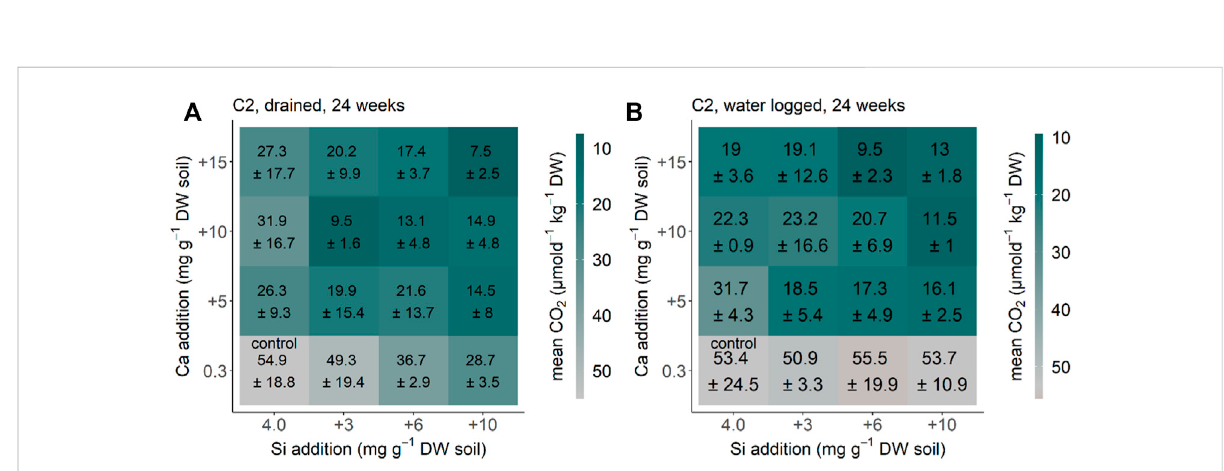
FIGURE 2 CO 2 productionfortheSiberiaCherskyC2fromNE-Russiaafter24 weeks (A) drainedand (B) waterloggedincubation.Eachsquarerepresentsa treatment(n=5)withSi(+0,+3,+6,and+10 mg g − 1 DW)andCa(+0,+5,+10,and+15 mg g − 1 DW).Colorrepresentsthedifferencesofthetreatment CO 2 production in comparison to the control treatment, with green – blue showing a decreased CO 2 production and red showing an increased CO 2 production in comparison to the control